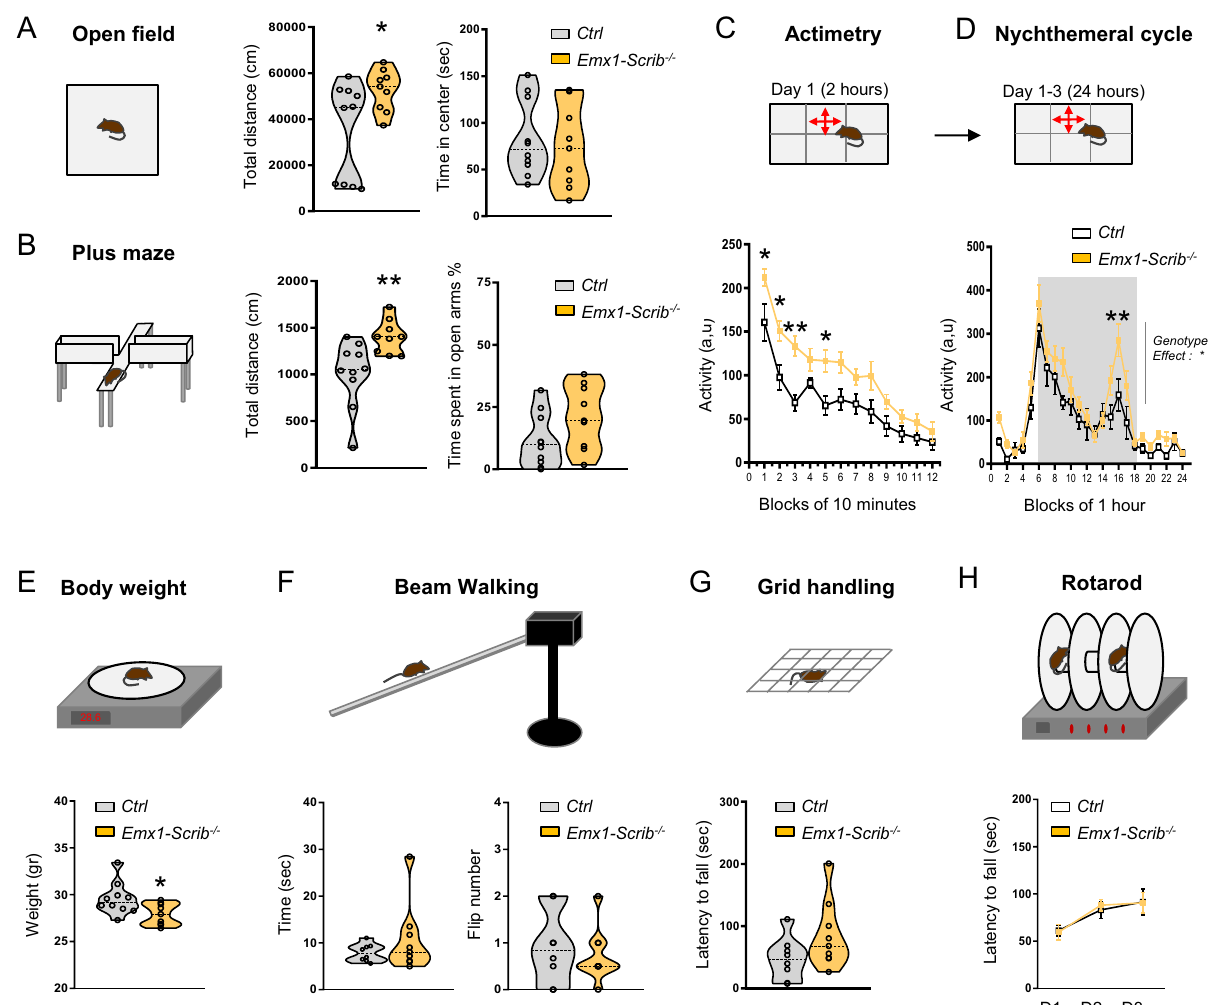
Figure 7. Increased activity without impaired motor coordination in Emx1-Scrib −/− mice. ( A ) Left panel, open field apparatus. Middle panel, spontaneous locomotor activity measured by the total distance in the open field test. Right panel, time spent in the center. ( B ) Left panel, plus maze apparatus. Middle panel, total distance moved in the plus maze. Right panel, time spent in open arms. ( C ) Upper panel, actimetry test apparatus. Lower panel, distance travelled measured in 10-min intervals across the 120-min test session in a novel home-cage (control: n = 6 mice; Emx1-Scrib −/− : n = 9 mice). ( D ) Upper panel, nychtemeral cycle test apparatus. Lower panel, distance travelled measured in 1 h intervals across the 24 h test session in a home cage. ( E ) Upper panel, balance apparatus. Lower panel, body weight of 10–11 week-old mice. ( F ) Upper panel, beam walking apparatus. Lower panel, time spent to reach the black box and total flip number. ( G ) Upper panel, Grid handling apparatus. Lower panel, Latency to fall the grid. ( H ) Upper panel, rotarod test apparatus. Lower panel, latency to fall in accelerating (4–40 rpm across 5 min) rotarod test on 3 consecutive days. Data are presented either as violin plots with single data point as a dot or as means ± s.e.m. from 6 to 10 mice per